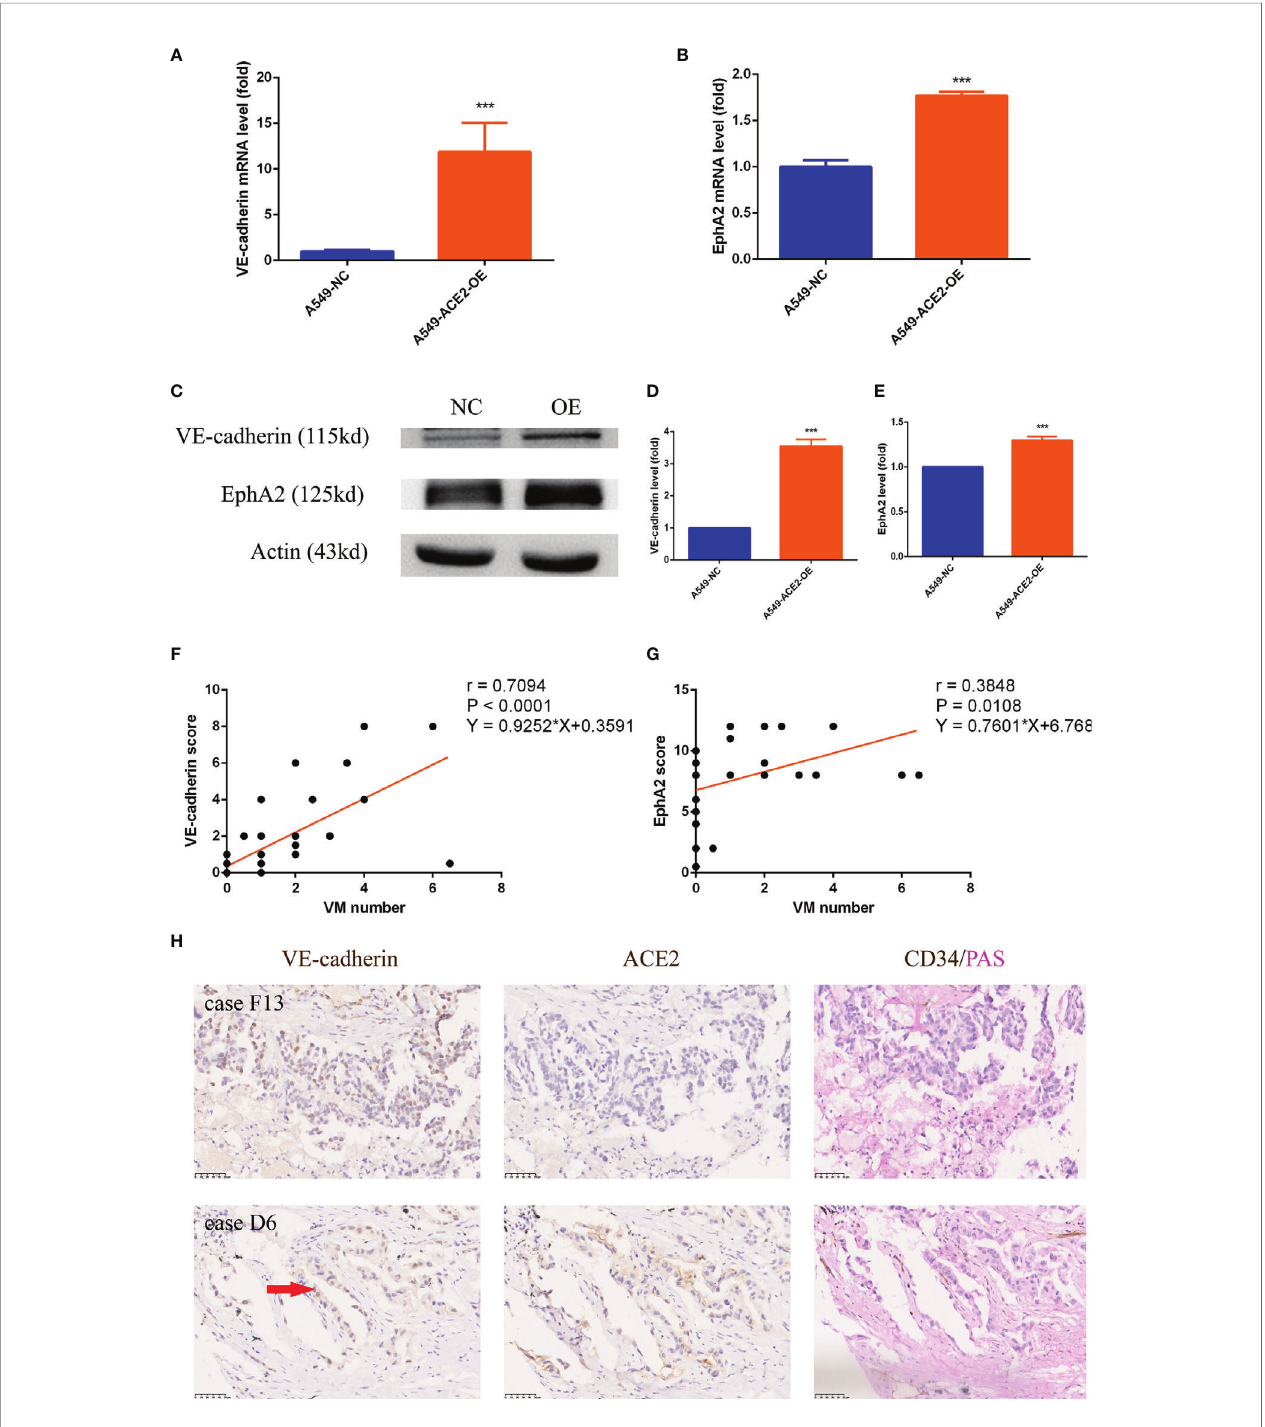
FIGURE 6 | VE-cadherin and EphA2 expression was upregulated in A549 cells and NSCLC tissues with impaired local RAS status. (A, B) RT-PCR experiment of VE-cadherin and EphA2 mRNA level in A549-ACE2-OE cells and control cells, Mean ± SD, n = 3, ***p < 0.001. (C – E) Western blot analysis and quanti fi cation of VE- cadherin and EphA2 expression level in A549-ACE2-OE cells and control cells, Mean ± SD, n = 3, ***p < 0.001. (F, G) Linear regressions of VM number and VE- cadherin (P < 0.0001) or EphA2 (P = 0.0108) score in TMA. (H) Typical tissue images of both groups stained with VE-cadherin, ACE2 or CD34/PAS. Case F13 with ACE2 low status was provided with rambling VM covered by tumor cells which only expressed VE-cadherin in nuclei; case D6 with ACE2 high status had ordered VM lined by tumor cells expressing VE-cadherin in both nuclei and cytomembranes. Red arrow: VE-cadherin membrane